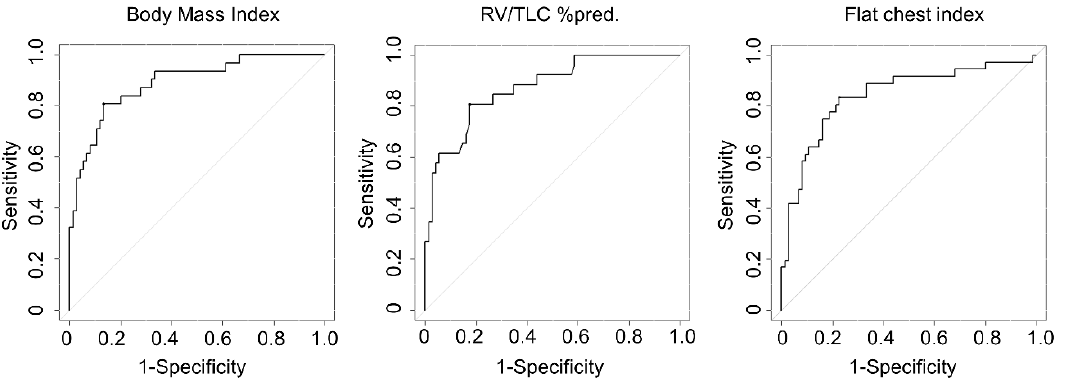
Figure 3. The results of the receiver operating characteristic (ROC) curve analyses. The area under curves of the Body Mass Index (0.875) and RV/TLC %pred. (0.878) were slightly higher than that of the flat chest index (0.837).